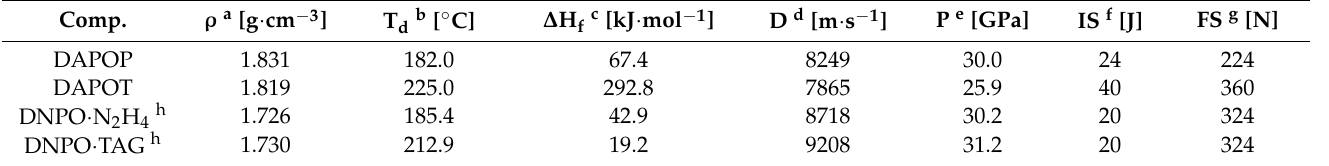
Table 2. Energetic and physicochemical properties of DAPOP and